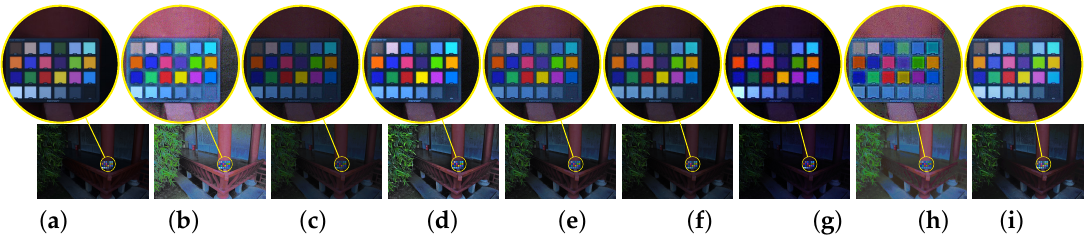
Figure 6. Brighten the color checker board. ( a ) The ground truth of color checker board, ( b ) is by using